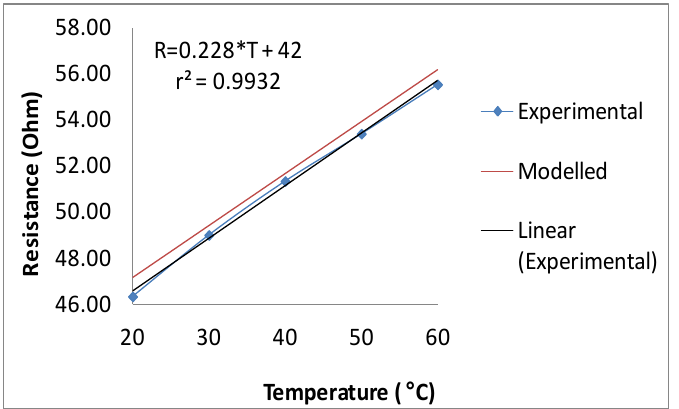
Figure 3. Comparison of experimental and modelled temperature-resistance relationship of sample